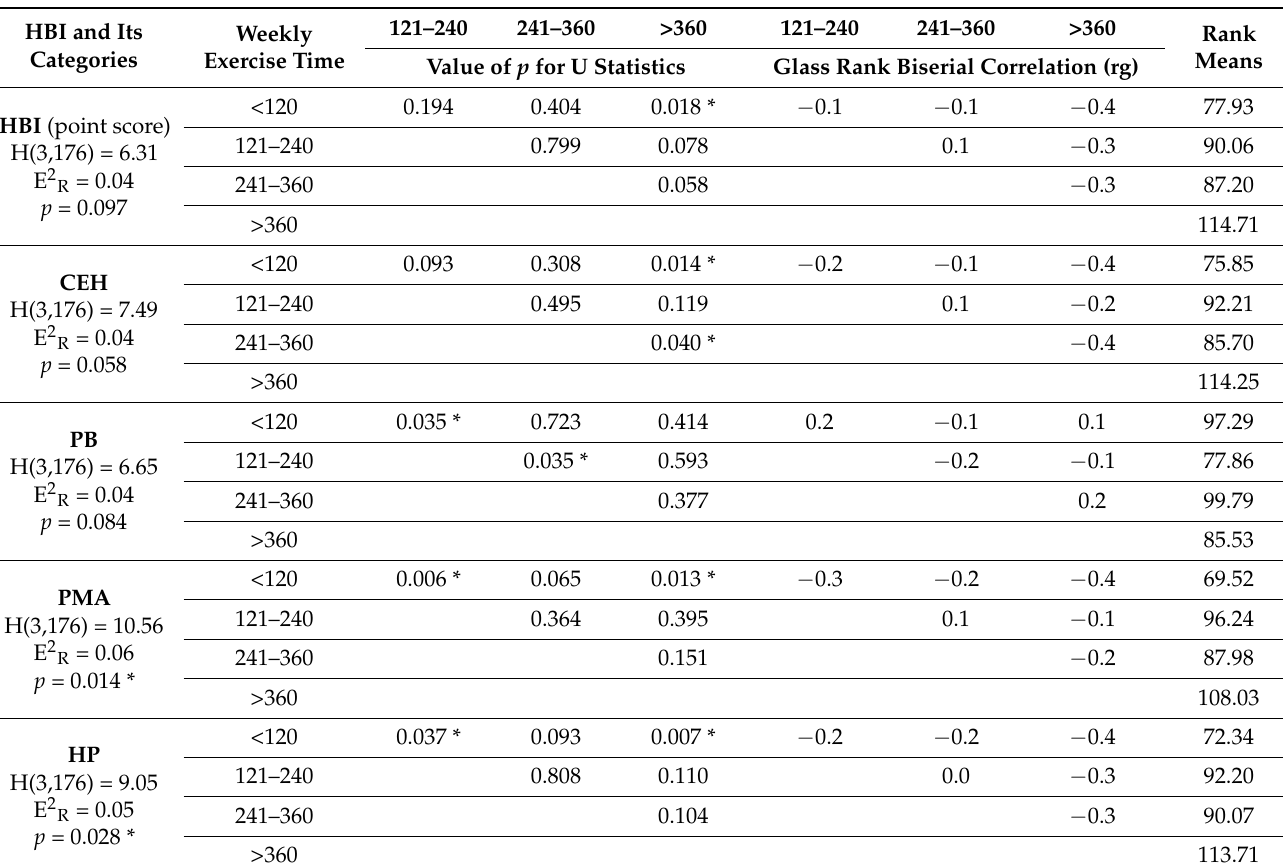
Table 3. Health behaviors of people practicing wheelchair basketball, wheelchair rugby and para- rowing depending on the weekly exercise time (the H test, E 2 R , the U test,